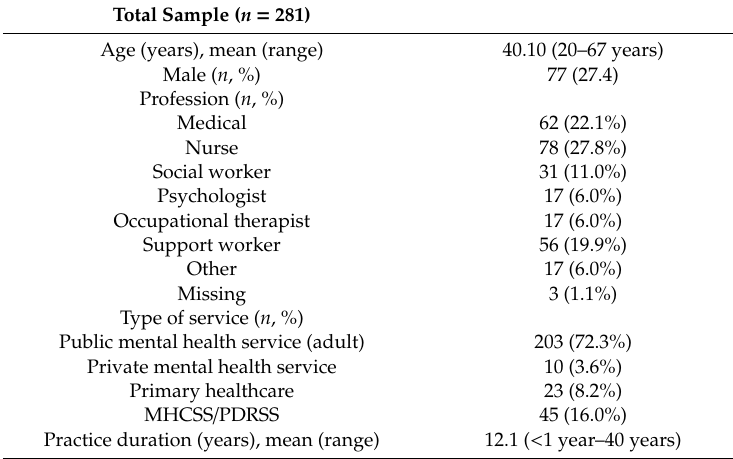
Table 1. Clinician